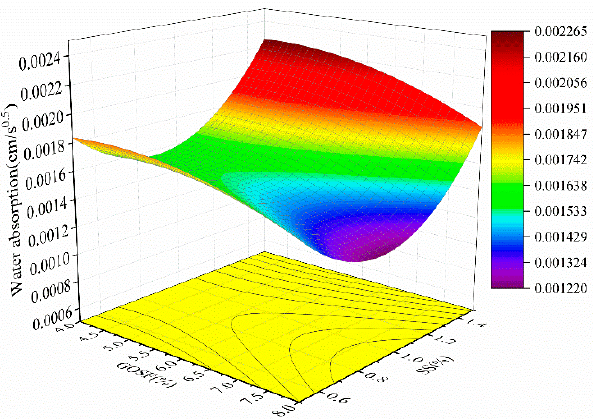
Figure 12. The effects of GOSF and SS on water absorption of samples.